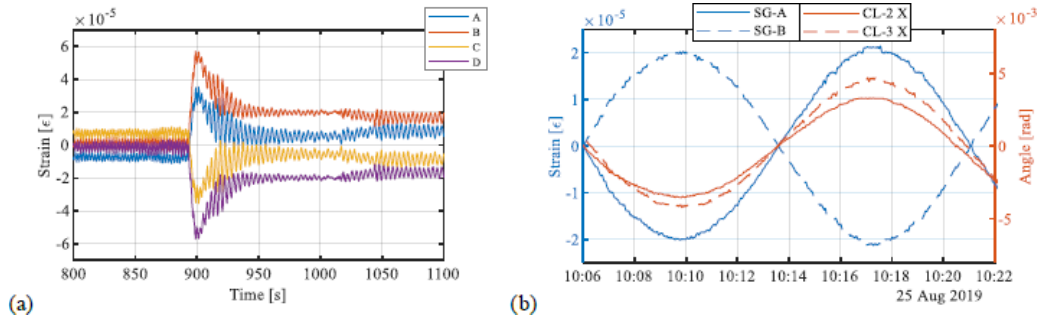
Figure 12. Tower-monitoring system strains and rotations: (a) example of strain time series; (b) strain and rotations during nacelle yawing; SG: strains measured by strain gauges; CL: rotations measured by clinometers (see sensor positions in Fig.